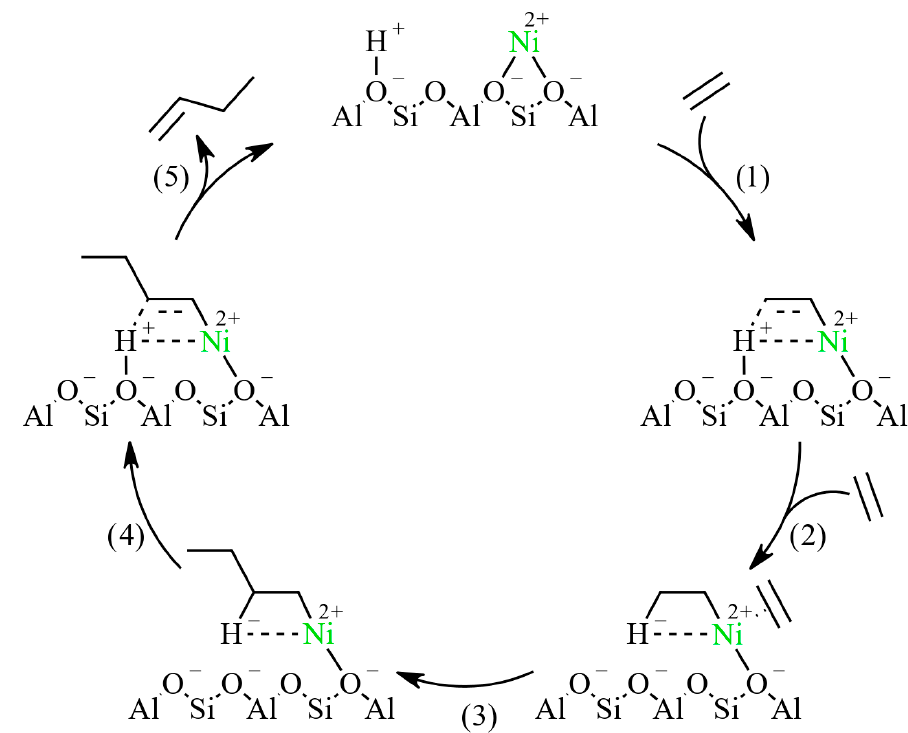
Figure 5. Proposed mechanism for formation of a nickel-hydride site involving a Brønsted acid: (1) ethylene adsorption over a Ni 2+ site and an adjacent Brønsted site, (2) formation of [Ni(II)-H] + center followed by coordination of another ethylene molecule, (3) insertion to form adsorbed butyl, (4) recovery of the Brønsted site, and (5) desorption to form a product followed by recovery of the Ni 2+ site.